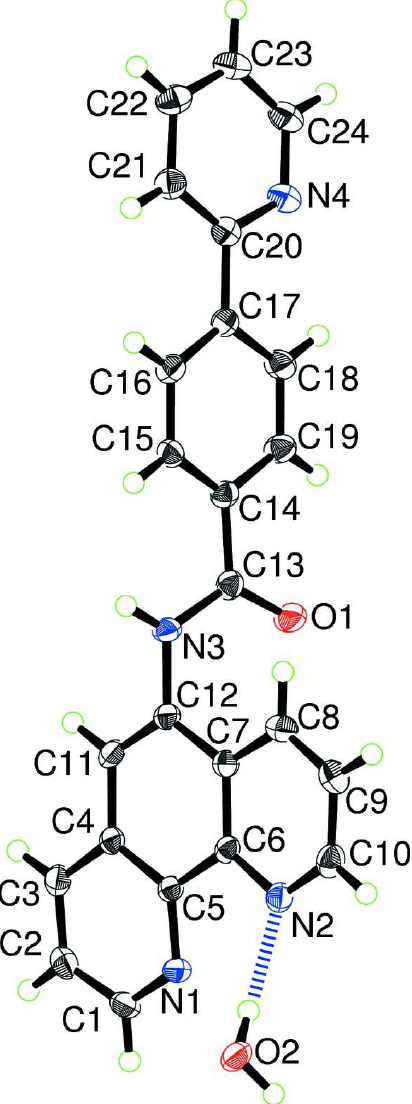
Figure 1 The molecular structure of (I) showing the atom-labeling scheme. Displacement ellipsoids are drawn at the 50% probability